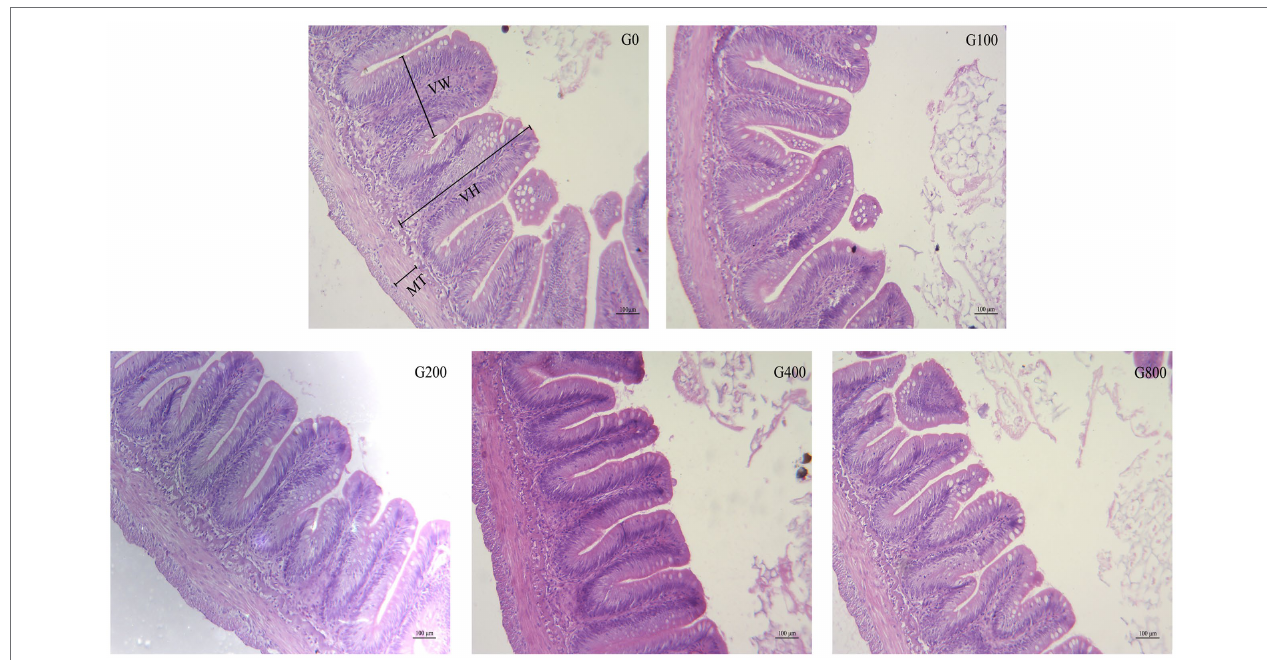
FIGURE 2 | The light micrograph in the triploid O. mykiss fed GSH diets. VH, VW and MT represent villus height, villus width and muscular thickness.